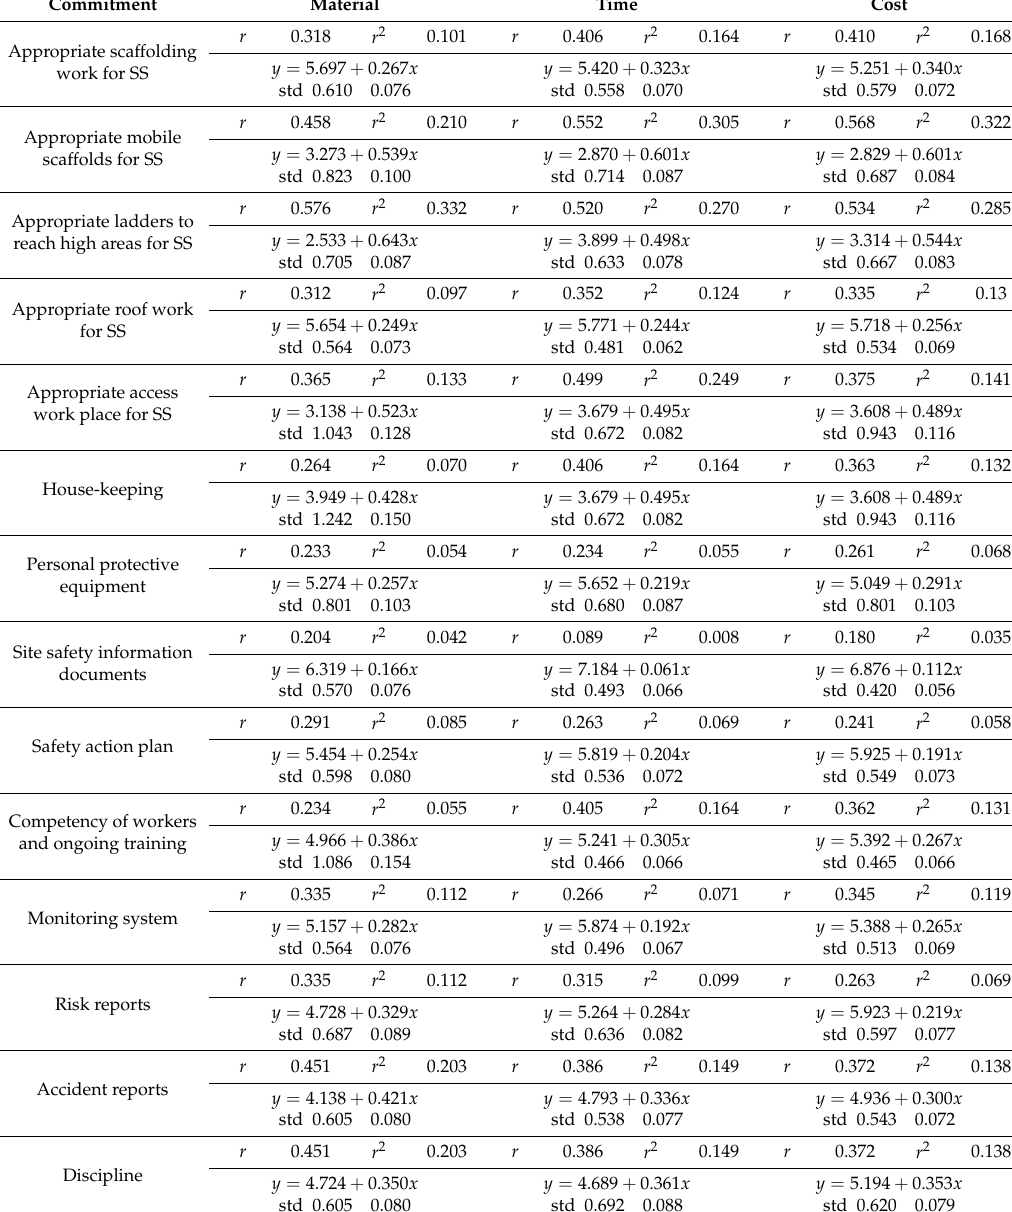
Table 7. Predictive equations to minimize waste (materials, time and cost) according to the degree of commitment to each factor of SS during